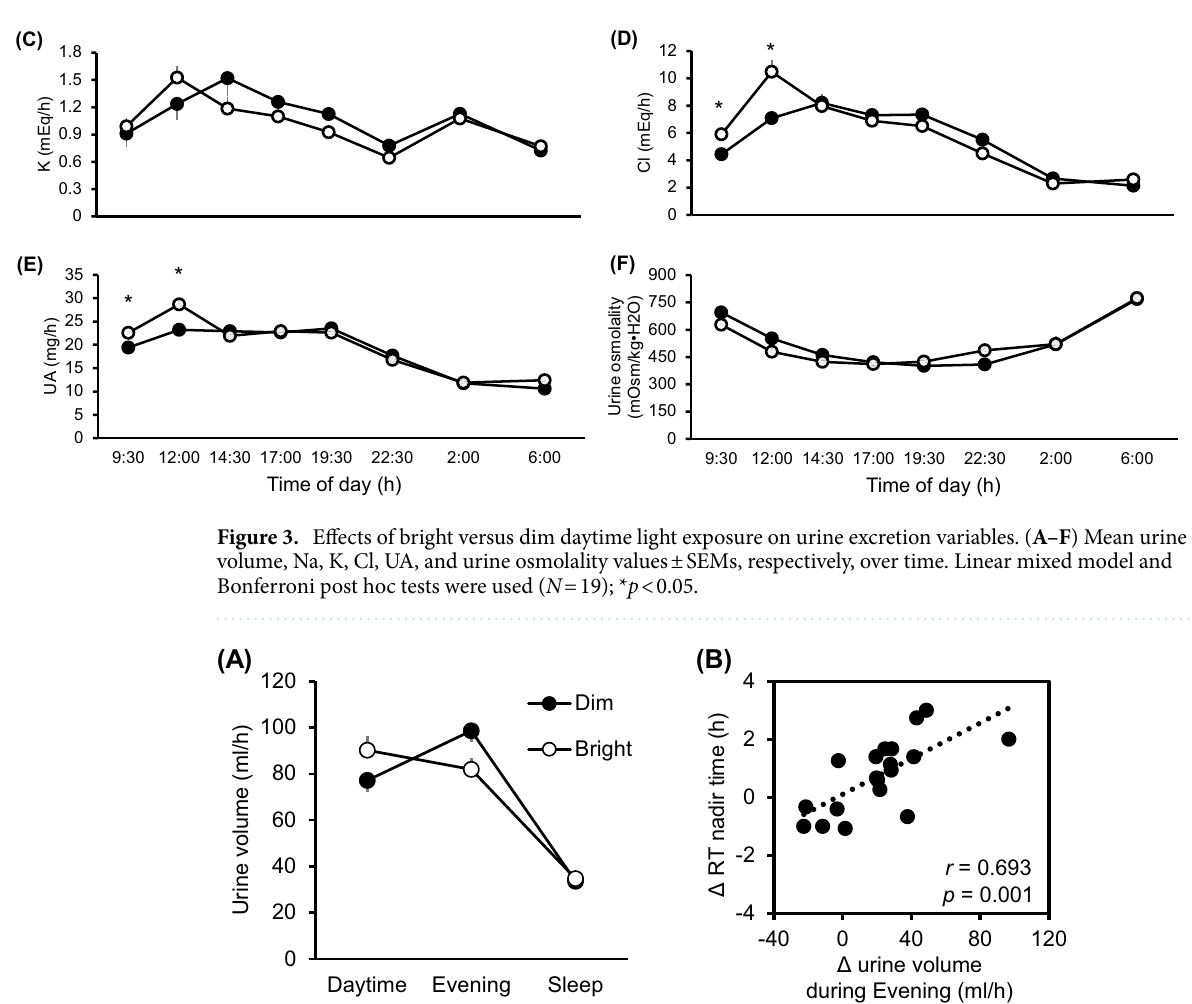
Figure 4. Effects of daytime light exposure condition on urine volume and analysis of the relationship between inter-condition differences in RT nadir time and inter-condition differences in evening-period urine volumes (both, N = 19). ( A ) Mean urine volumes collected (± SEMs) during daytime hours (08:00–18:00 h), evening hours (18:00–24:00 h), and sleeping hours (24:00–08:00 h). ( B ) Differences in RT nadir time between the dim and bright light conditions correlated very significantly with differences in evening-period urine volumes between the two light conditions. Differences were calculated by subtracting bright condition values from dim condition values within each noted time interval on day 3. Pearson correlation statistics are shown within the correlation